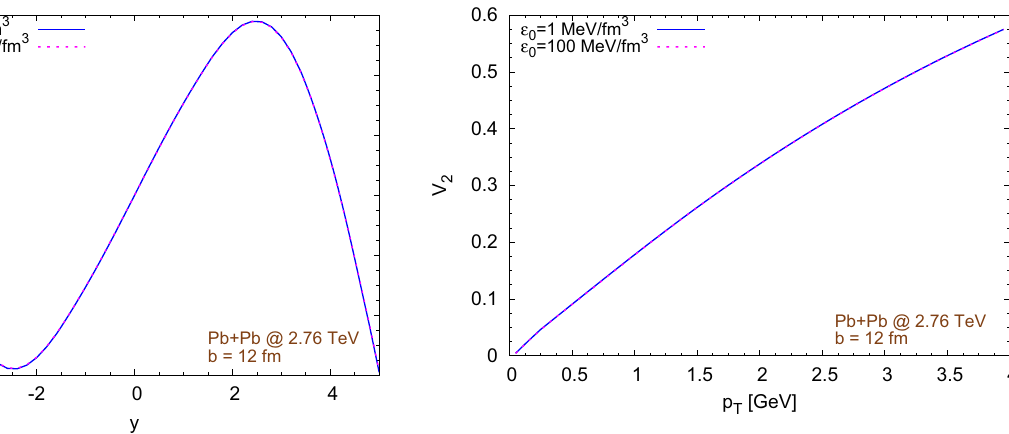
Fig. 17 Evaluation of the impact of the energy density pedestal intro- flow of charged pions vs rapidity. Right figure: elliptic flow of charged duced to stabilize the code on the Fourier harmonics v 1 , 2 . The figures pions at mid-rapidity vs transverse momentum. We can notice how at √ s NN = 2 . 76TeVwithanimpactparameter refertoPb+Pbcollisionsat LHC energies the high energy density background has a very limited b = 12fm and without magnetic fields. Left figure: integrated directed effect on the results, at least in the ranges shown in the figures